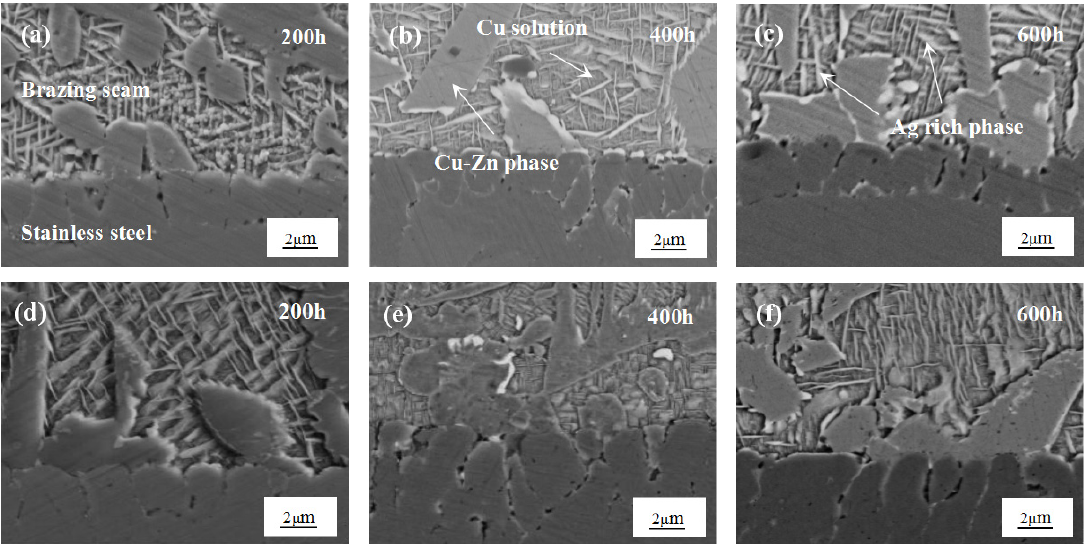
Figure 2. Interfacial microstructure of the Ag16.5CuZnSn-xGa brazed joints after aging treatment: ( a – c ) Ag16.5CuZnSn, ( d – f ) Ag16.5CuZnSn-2Ga.